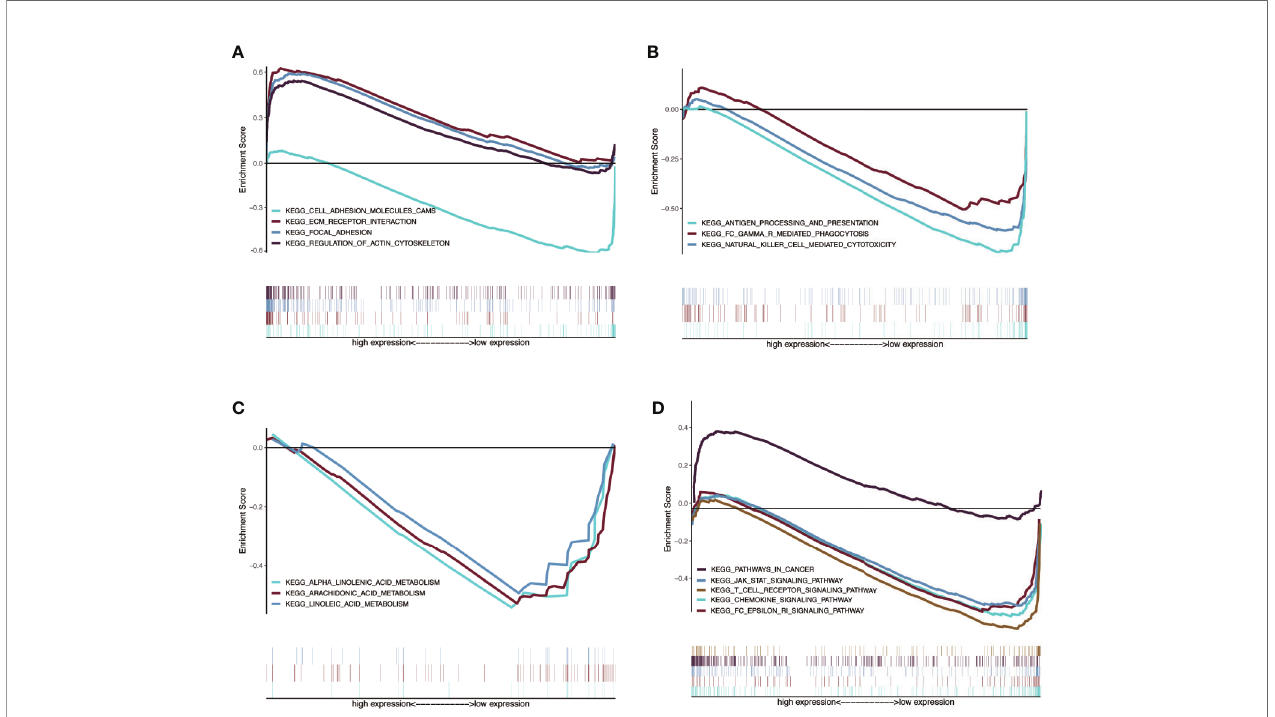
FIGURE 9 | Enrichment plots from multiple GSEA. (A) Intercellular matrix remodeling: cell adhesion molecules cams, focal adhesion, ECM receptor interaction, regulation of actin cytoskeleton. (B) Tumor killing: antigen processing and presentation, Fc gamma r mediated phagocytosis, natural killer cell mediated cytotoxicity. (C) Metabolic reprogramming: alpha linoleic acid metabolism, arachidonic acid metabolism, linoleic acid metabolism. (D) Tumor immune-related pathways: chemokine signaling pathway, Fc epsilon RI signaling pathway, JAK-STAT signaling pathway, T-cell receptor signaling pathway, pathways in